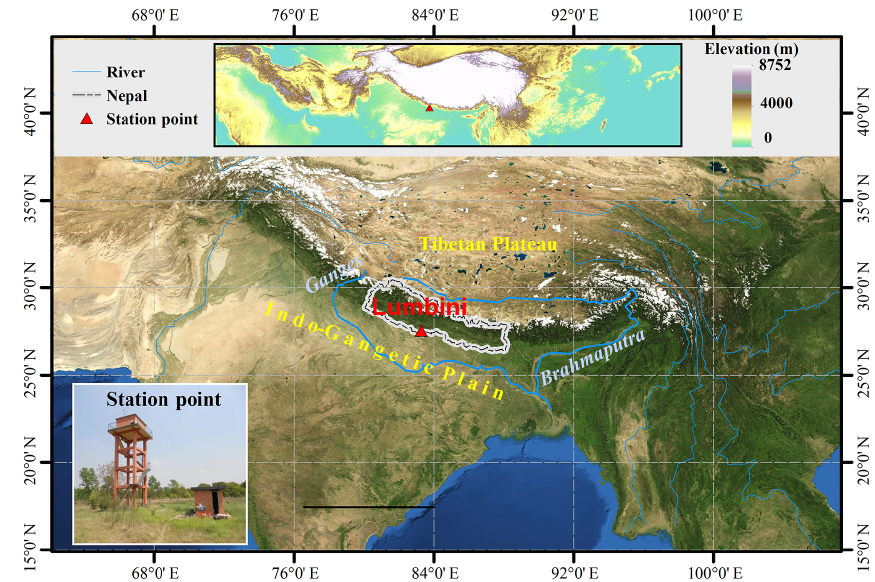
Figure 1. Map showing the location and general setting of the sampling site of Lumbini in the northern edge of the Indo-Gangetic